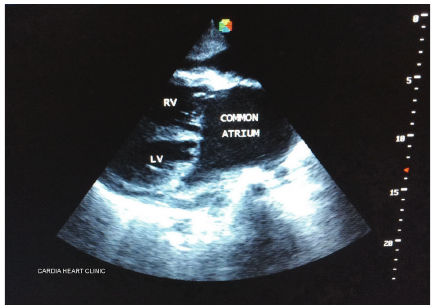
Figure 2: Two-dimensional echocardiogram parasternal long-axis view of the common